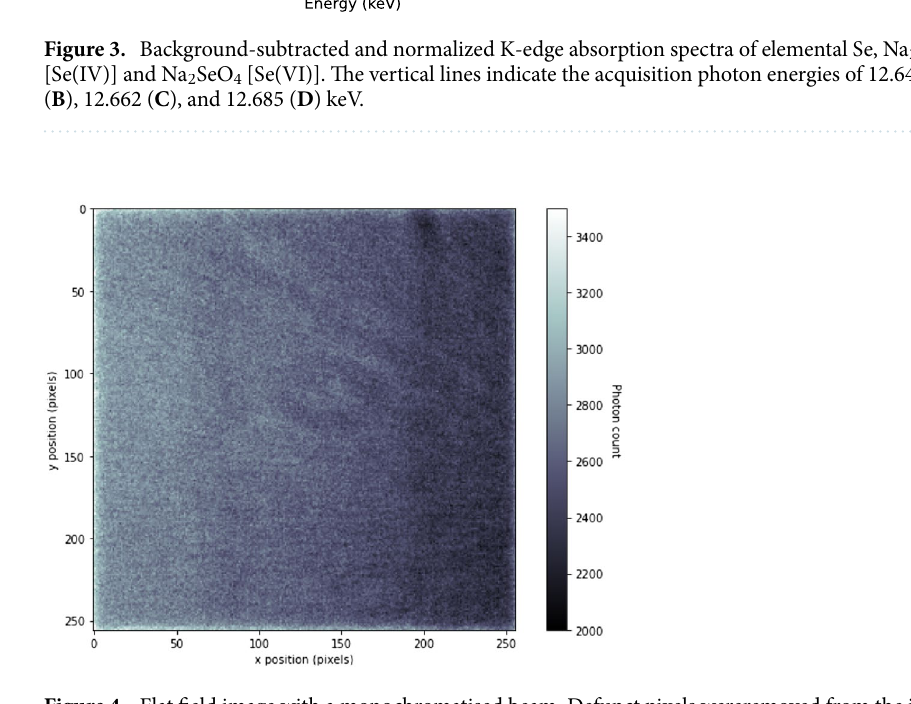
Figure 4. Flat field image with a monochromatised beam. Defunct pixels wereremoved from the image by replacing them with the median value of the neighbouring pixels (for the raw image see Supplementary